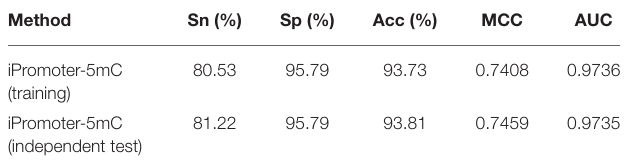
TABLE 4 | The 5-fold cross validation results on the training set and the independent test set of human hepatocarcinoma cell lines.